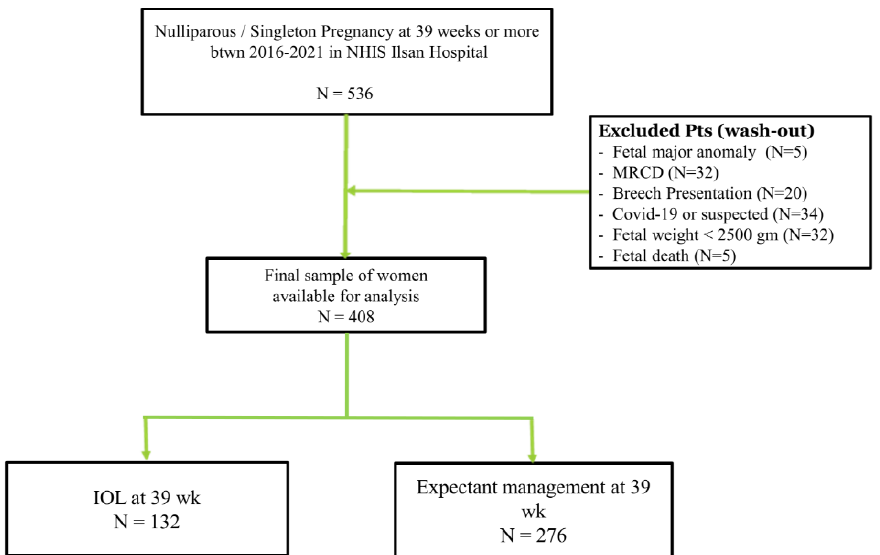
Figure 2. Study flow chart. IOL, induction of labor; MRCD, maternal request cesarean delivery; NHIS, National Health Insurance Service; Pts, patients.